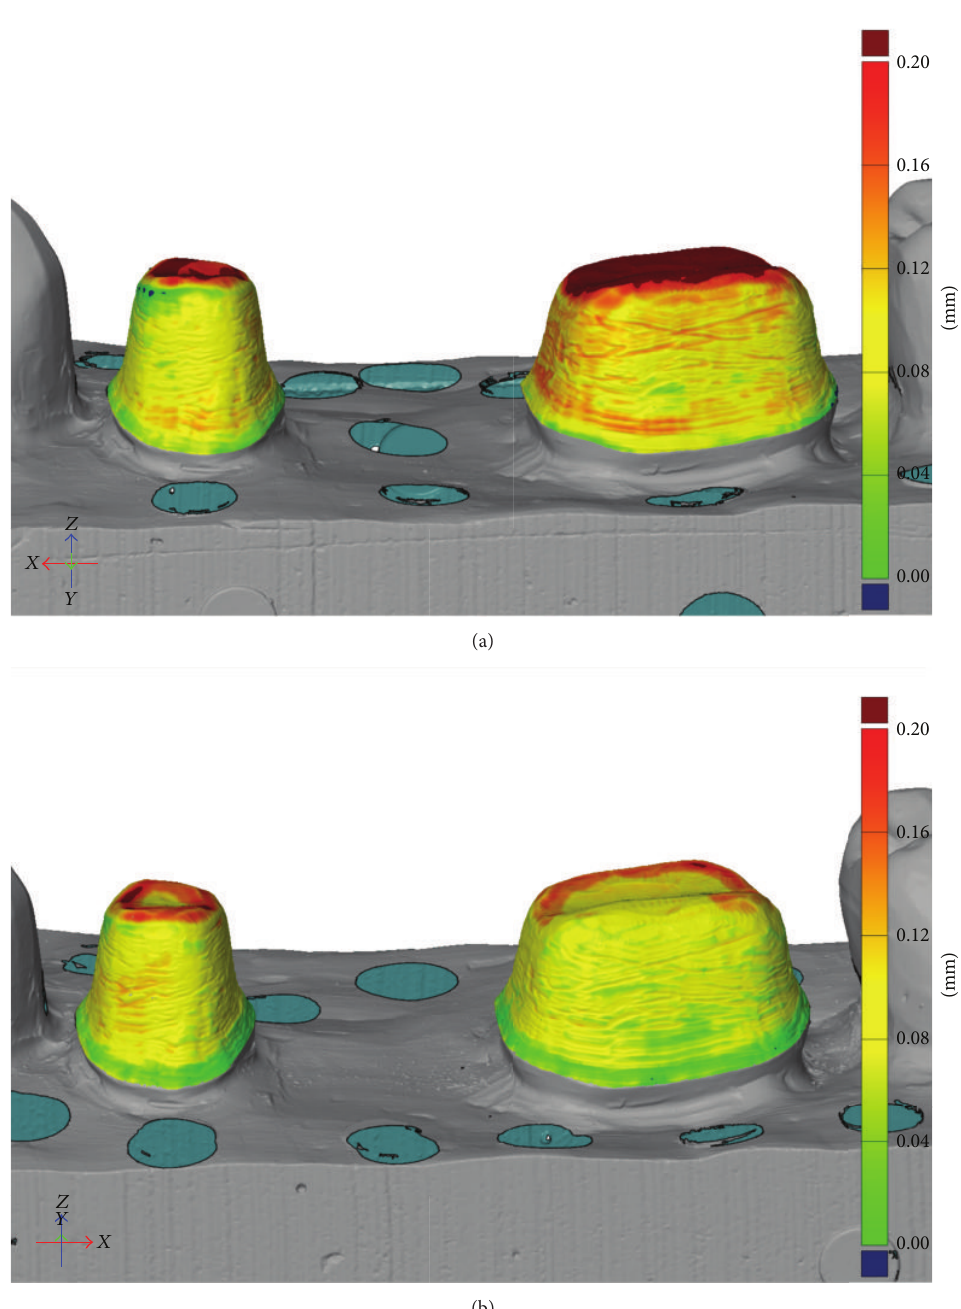
Figure 2: (a) Fit analysis of FDPs produced with conventional impression technique. The distance from abutment to inside of FDP is represented by color. Green = 0–40 𝜇 m; yellow = 70–110 𝜇 m; red = 160–200 𝜇 m. (b) Fit analysis of FDPs produced with digital impression technique. The distance from abutment to inside of FDP is represented by color. Green = 0–40 𝜇 m, yellow = 70–110 𝜇 m; red = 160–200 𝜇 m.